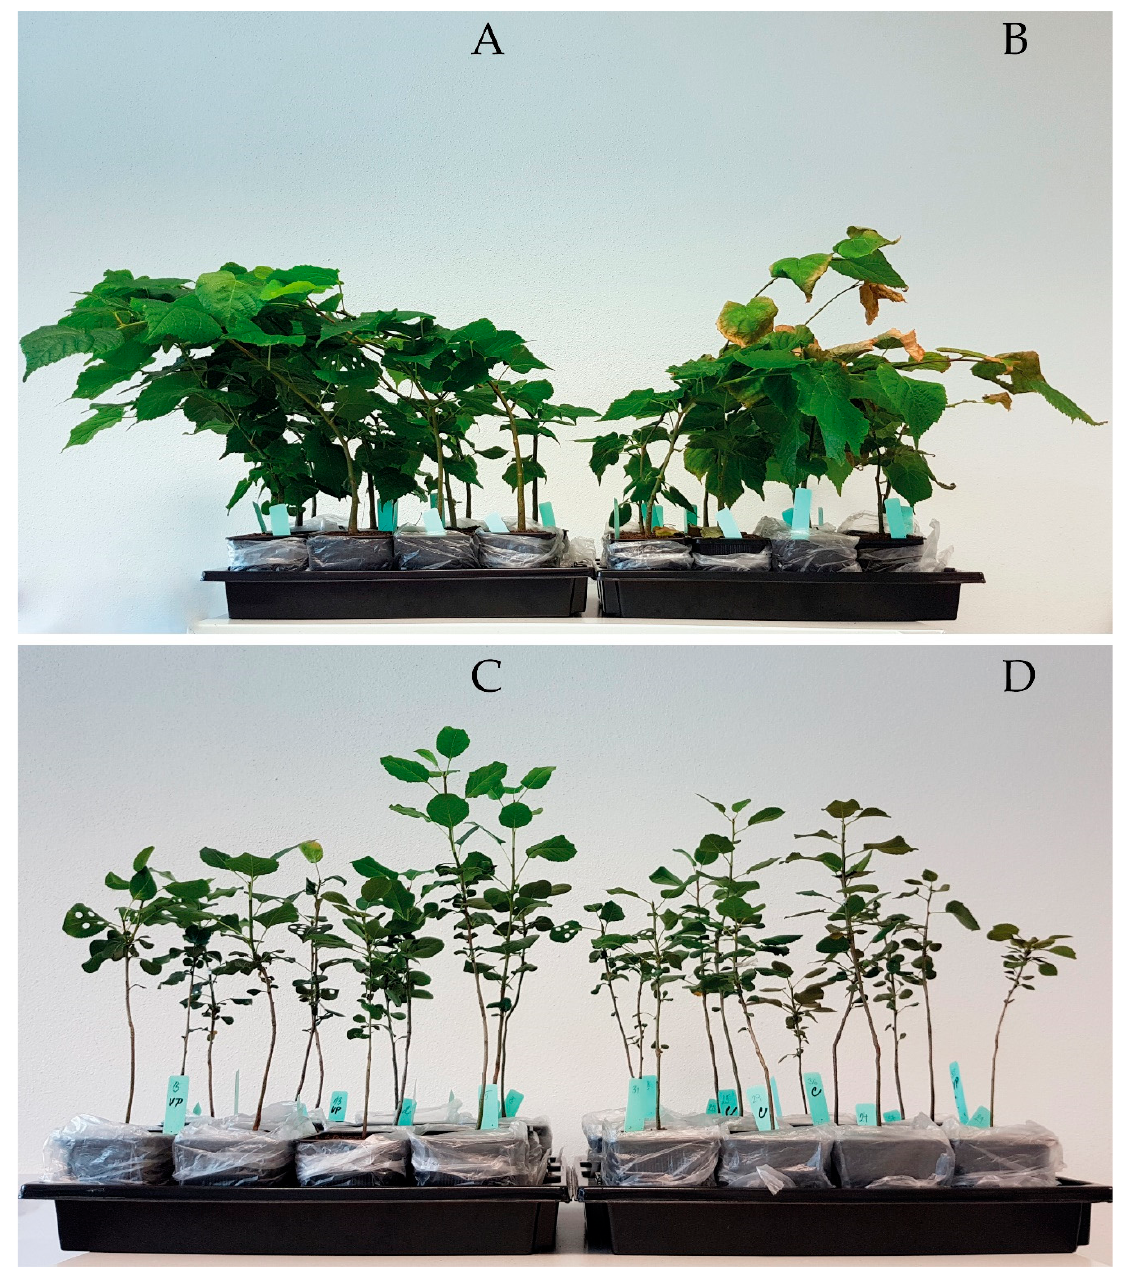
Figure 1. Two-year-old tree seedlings of ( A,B ) T. cordata and ( C,D ) P. pyraster; Control plants grown in the growth chamber for 50 days ( A,C ); and plants grown under the salt treatment (100 mM NaCl) ( B,D